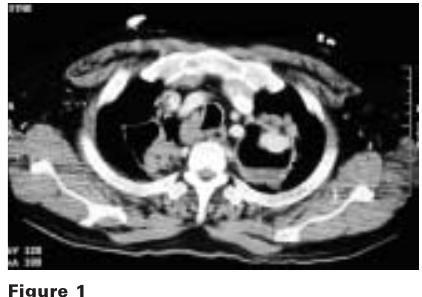
On the left side , selective catheterization of the apical left superior pulmonary artery demonstrates a voluminous pseudoaneurysm deriving from a subsegmental branch. On the right side, angiogra- phy shows complete occlusion of the involved branch and no filling of the pseudoaneurysm after the embolization with